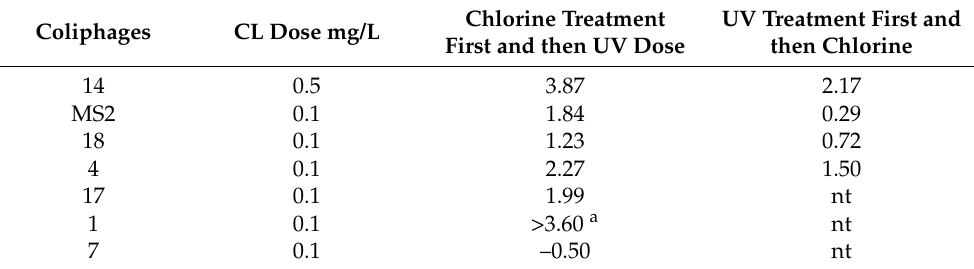
Table 4. Synergy values of coliphages when chlorine treatment with 0.1 or 0.5 mg/L was done first followed by UV of 22 mWs/cm 2 or UV treatment was done first followed by chlorine with 10 min contact time. Chlorine Treatment UV Treatment First and Coliphages CL Dose mg/L First and then UV Dose then Chlorine